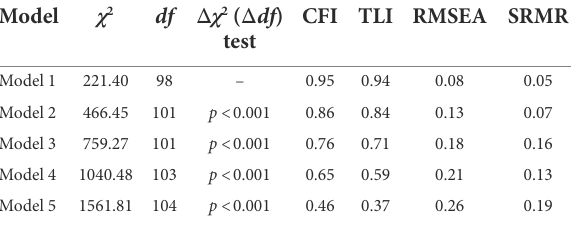
TABLE 2 Confirmatory factor analysis of measurement model ( N =